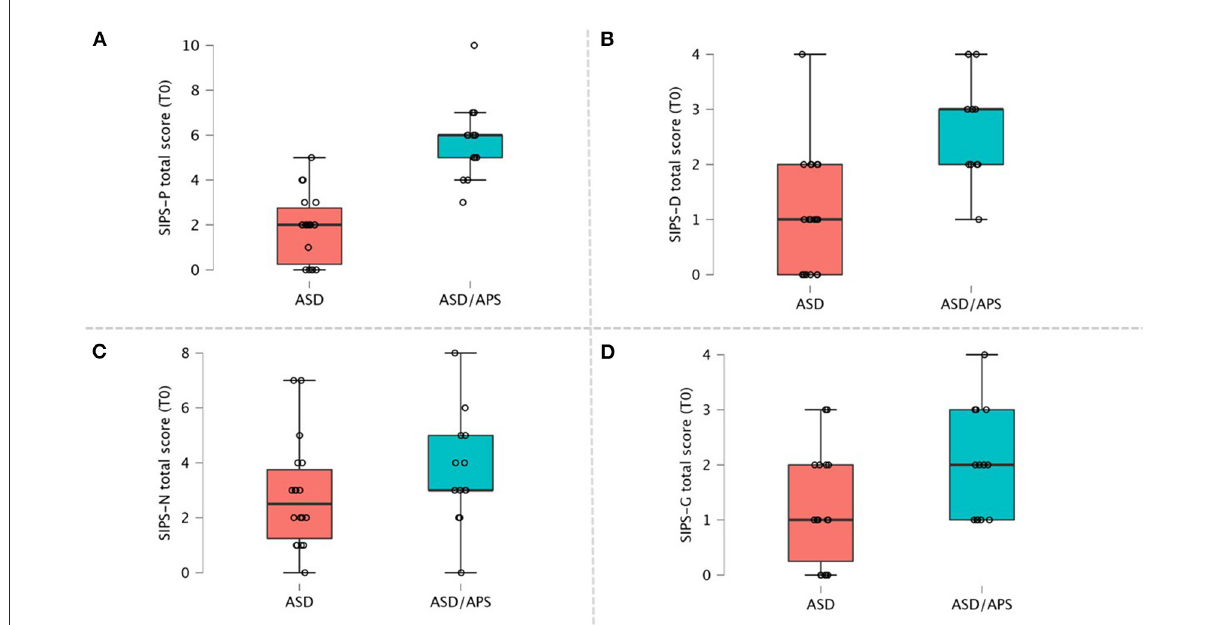
FIGURE1 SIPS scores domain within ASD and ASD/APS individuals. (A) SIPS Positive symptoms total score; (B) SIPS Disorganized symptoms total score; (C) SIPS Negative symptoms total score; (D) SIPS General symptoms total